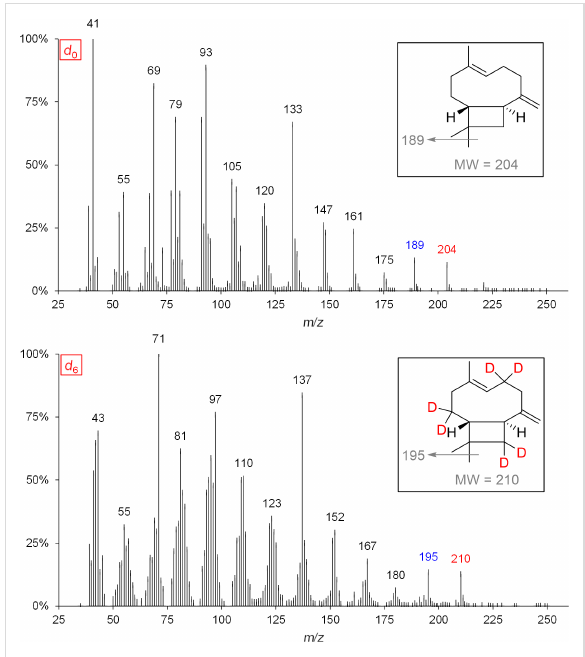
Figure 11: MS spectra and expected labeling patterns of d 0 -( E )- β - caryophyllene and d 6 -( E )- β -caryophyllene after successful administra- tion of d 2 -DOX to isolated exocarp of grapes of the red wine variety Lemberger.